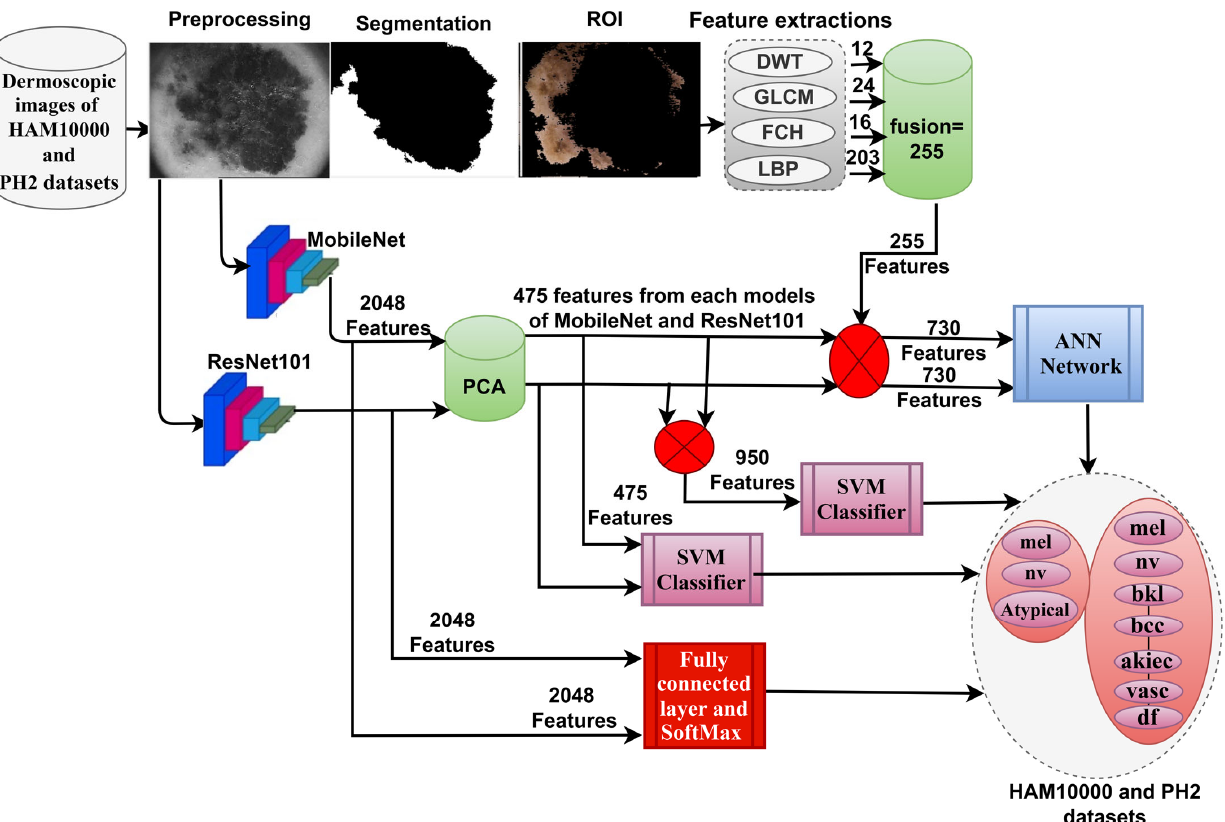
Figure 1. The methodological framework for dermoscopic image analysis to classify the HAM10000 and PH2 datasets for early detection of skin lesions. and PH2 datasets for early detection of skin